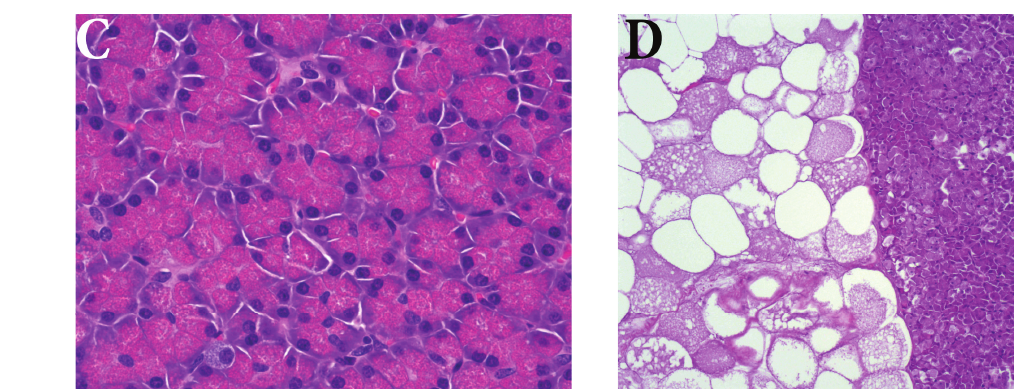
Figure 4: Pancreatic